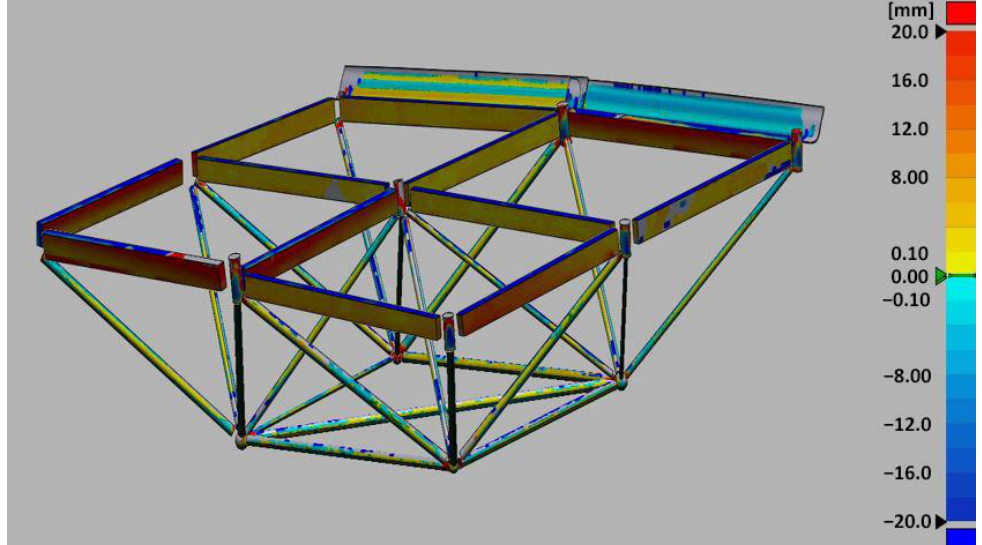
Figure 37. Reconstructed model deviation analysis with respect to the survey data for the first mesh grid. Table 5. The LoR evaluation for the first grid, based on deviation from the survey data.